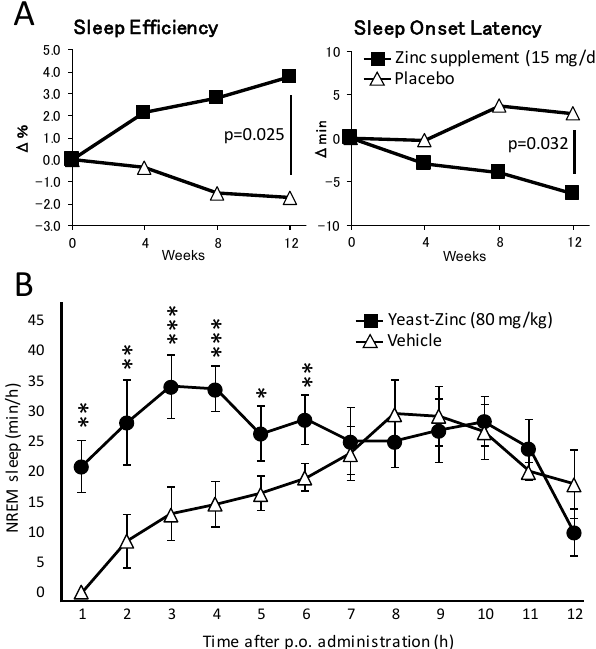
Figure 1. Dietary zinc improves sleep quality in humans and increases NREM sleep in mice. ( A ) Two groups of 30 volunteers absorbed daily 15 mg of zinc (in 40 g of Pacific oysters) or placebo (40 g of scallops). After 12 weeks of supplementation, sleep efficiency and sleep onset latency improved in the group treated with zinc compared to the control group. ( B ) Oral administration of zinc-containing yeast extract (80 mg/kg) in mice at the onset of dark time increased the amount of NREM sleep for 6 h compared to mice receiving vehicle. * p < 0.05, ** p < 0.01, *** p < 0.001 compared with vehicle treatment.